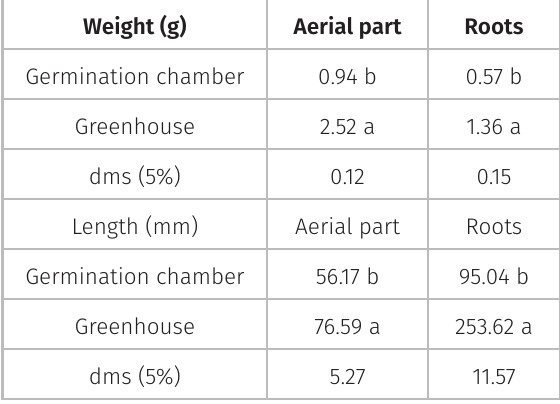
*Averages in the same column followed by the same letter do not significantly differ by the Tukey test (p < 0.05). dms: value of the least significant difference for the chosen